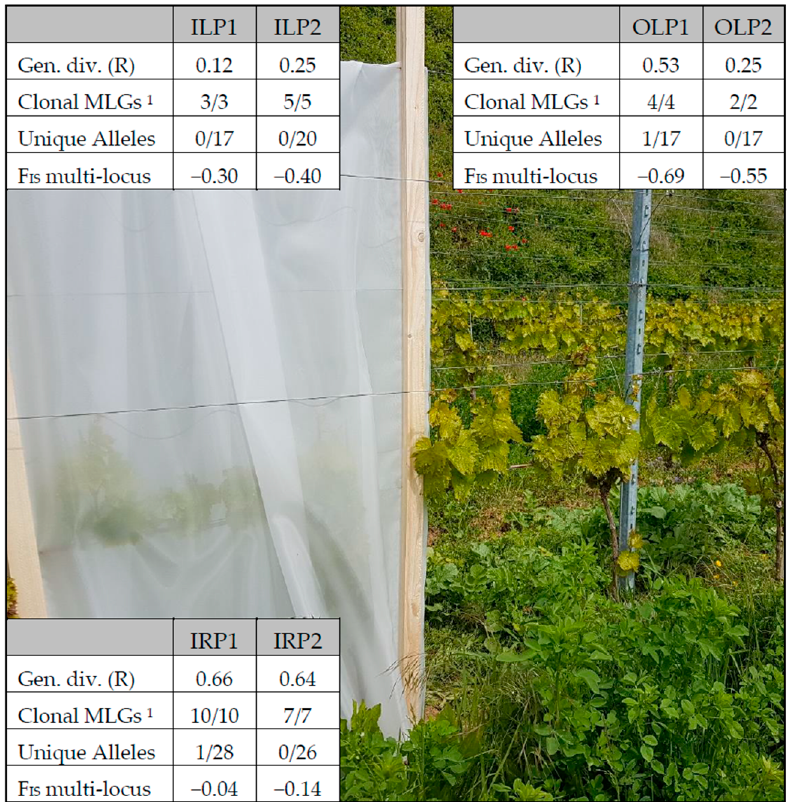
Figure 3. Genetic diversity parameters for phylloxera populations in the 2019 exclusion netting experiment. Samples were taken from leaf populations inside the enclosure (ILP), roots inside the enclosure (IRP), and leaves outside the enclosure (OLP), in the two vineyards Bahlingen E1 and E2. 1 Number of true clonal MLGs ( p sex < 0.01), per total recurring MLGs.